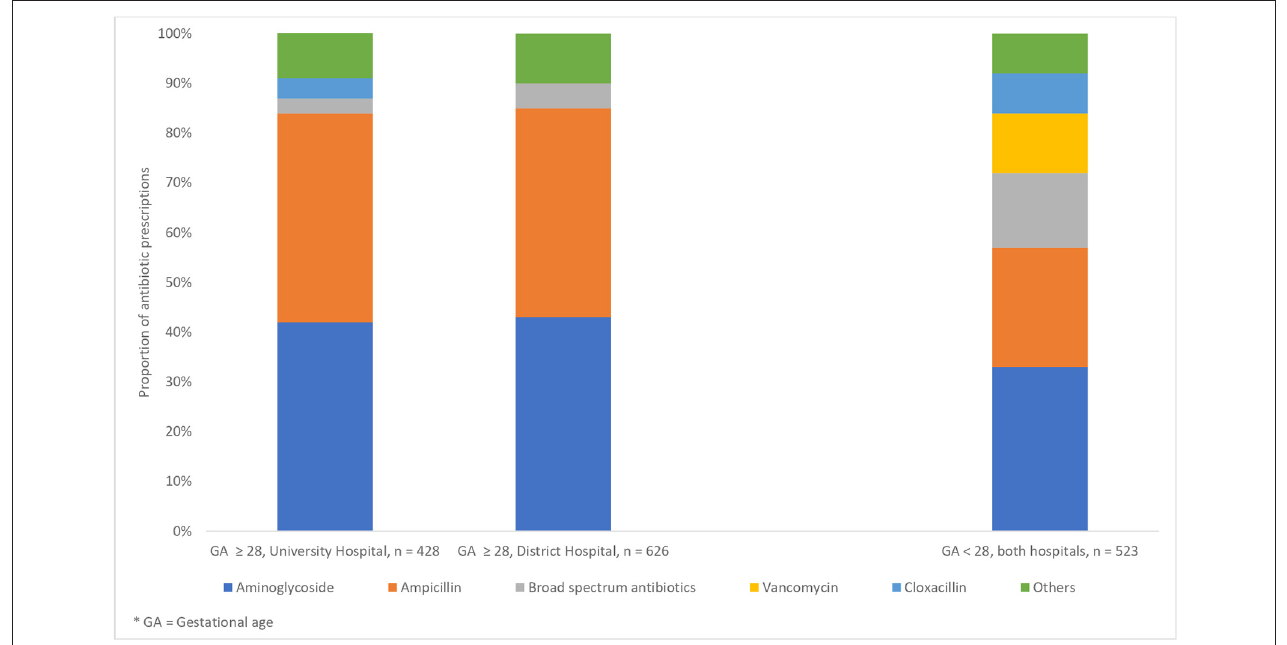
FIGURE 1 | Distribution of antibiotic prescriptions in two Norwegian neonatal units. Broad- spectrum antibiotics are defined as second- and third generation cephalosporins and carbapenems.